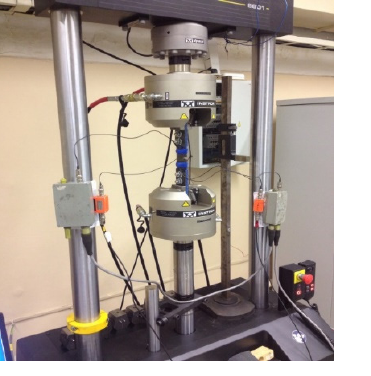
Figure 1. Experimental setup ( a ) and loading diagram ( b ).